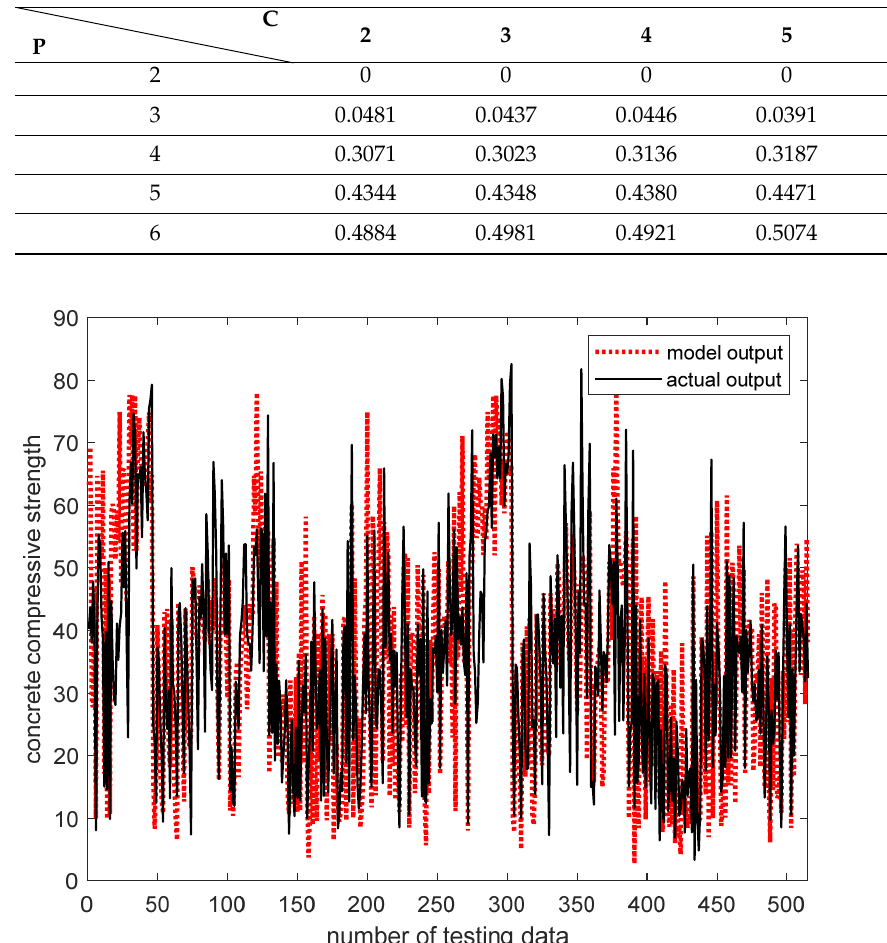
Figure 11. Comparison between the output of the CGK-based fuzzy granular model of the aggregated structure and the real output (uniform generation of contexts, number of contexts = 6, number of clusters = 4).